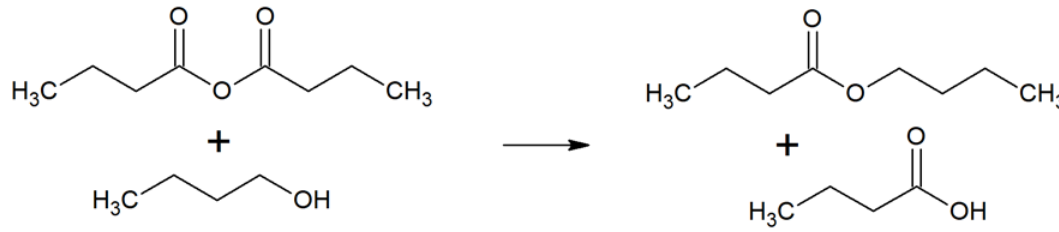
Figure 6. MDS plot with solvents highlighted in green (=high K T ), amber (=medium K T ), and red (=low K T ). Solvent names and K T values are shown as labels in the chart.